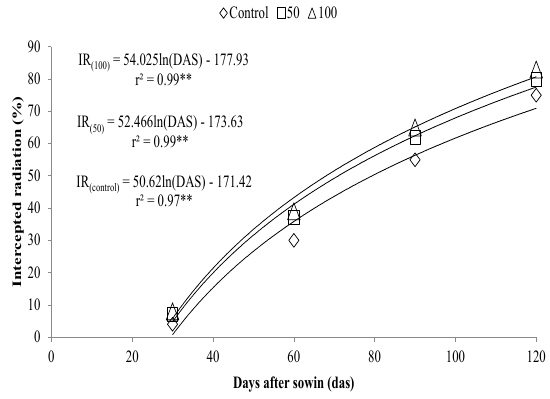
Figure 3 . Radiation intercepted by sunflower ( Helianthus annuus L.), as a function of three levels of potassium 0, 50 and 100 Kg ha -1 . Universidad Tecnológica de Tehuacán. Summer, 2017. das, days after sowing.